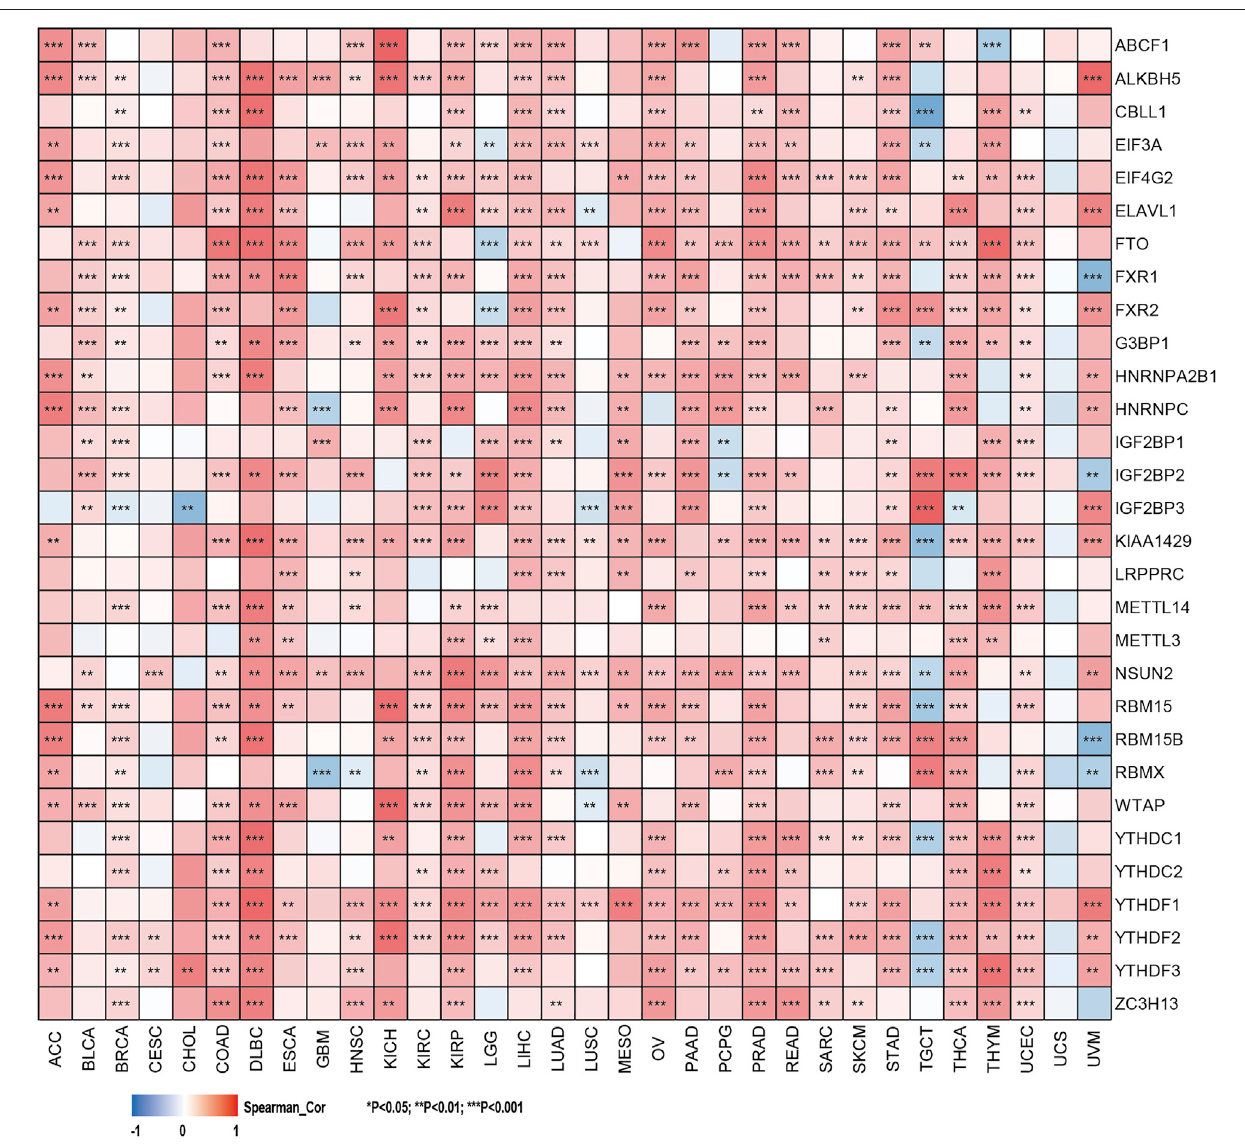
Frontiers in Genetics |